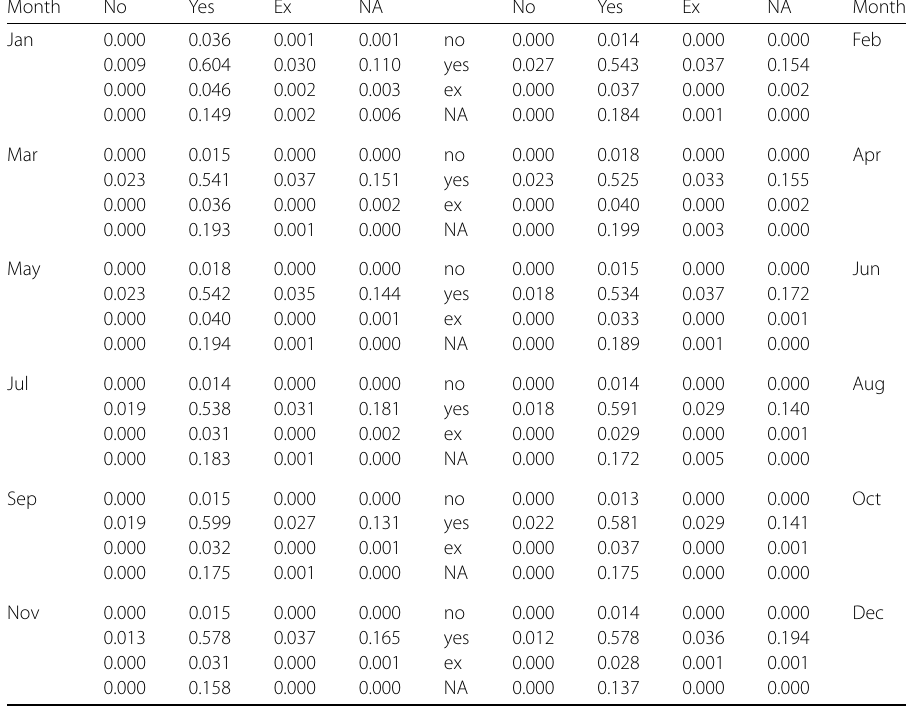
Table 4 Percentage of volume by customer status, the row indicates the status of the payer, the column the